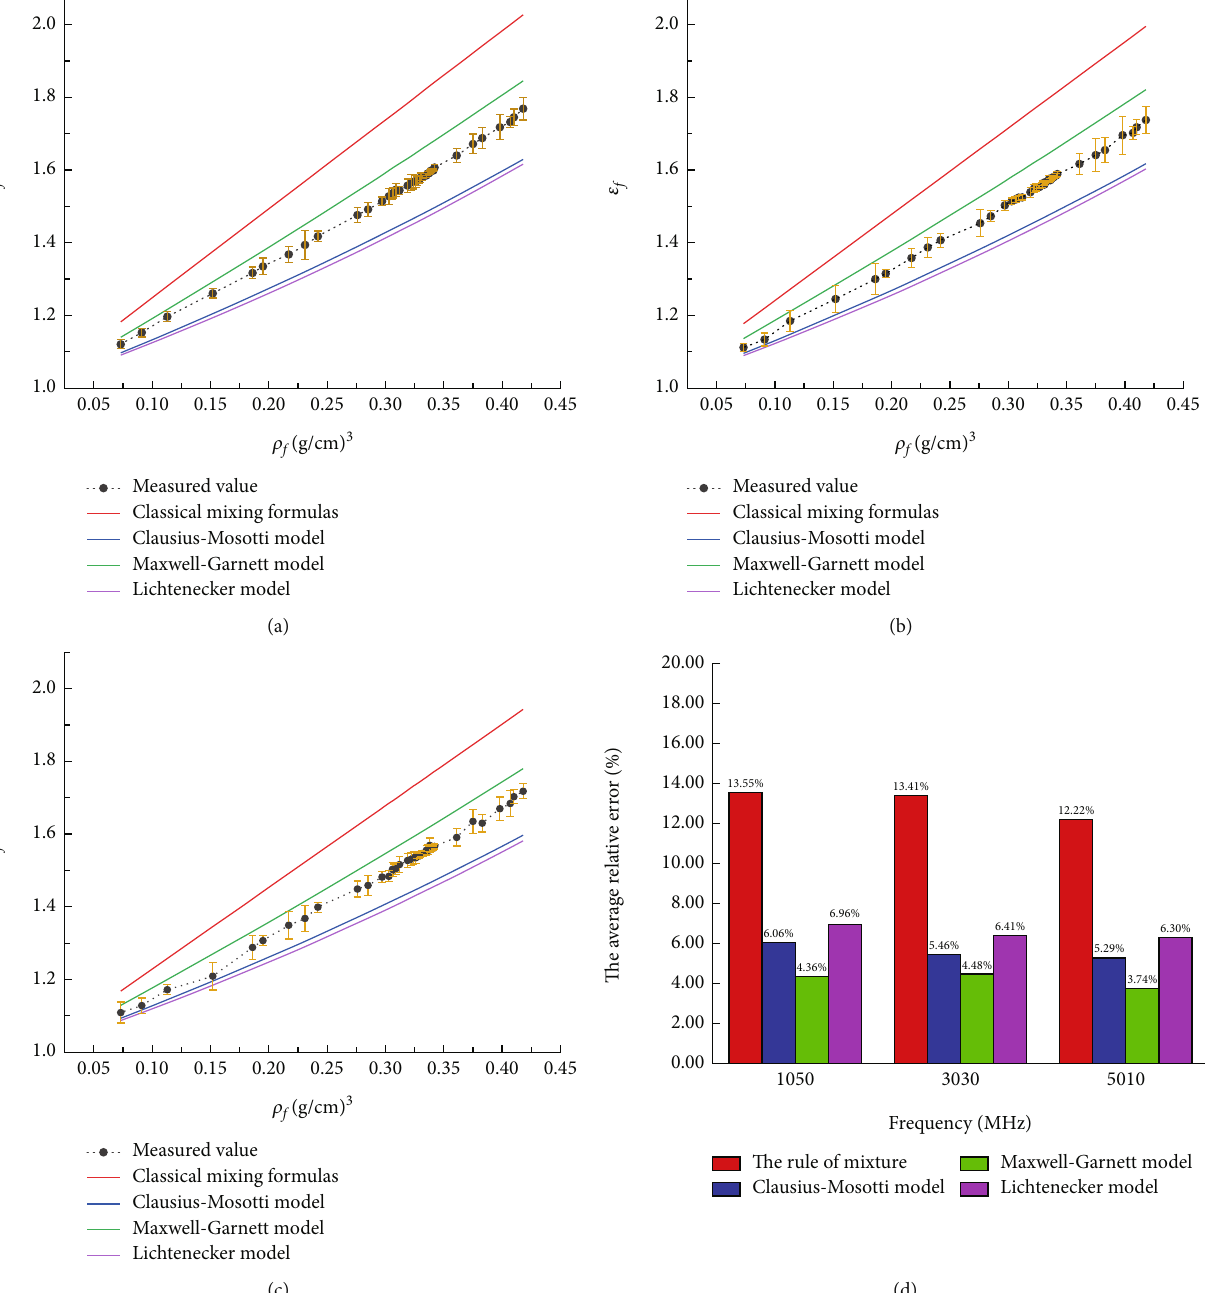
Figure 8: Model comparison and error analysis diagram. (a) f = 1050 MHz , (b) f = 3030 MHz , (c) f = 5010MHz ; (d) average relative error of di ff erent models at di ff erent